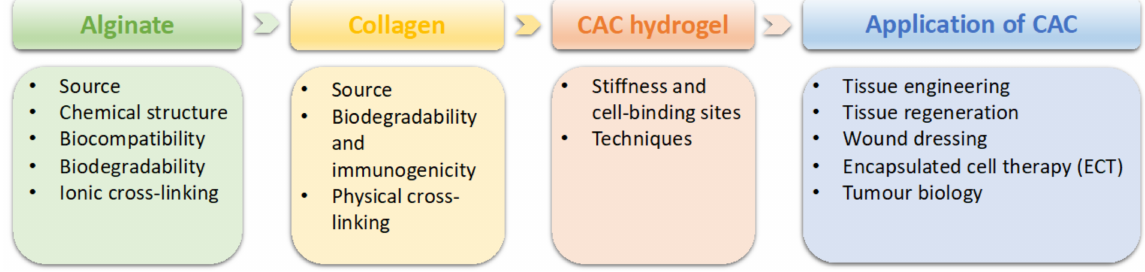
Figure 1. An overview of this review